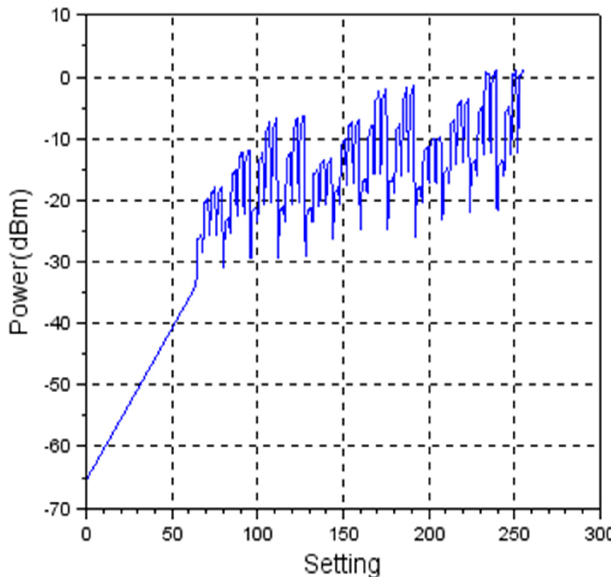
Figure 8. Non-linear variation of transmission power level vs. register setting.